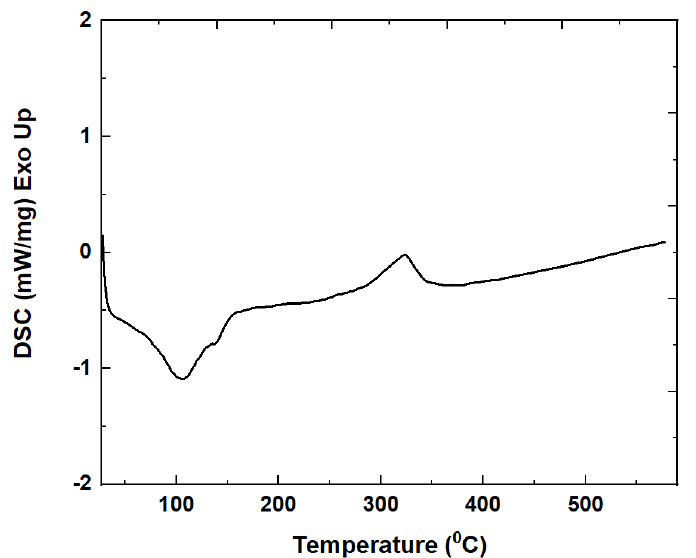
Figure 1. Differential scanning calorimetry (DSC) curves recorded on Yb 3+ /Er 3+ -doped SiO 2 -GdF 3 (x2Li mol.%) xerogel sample.